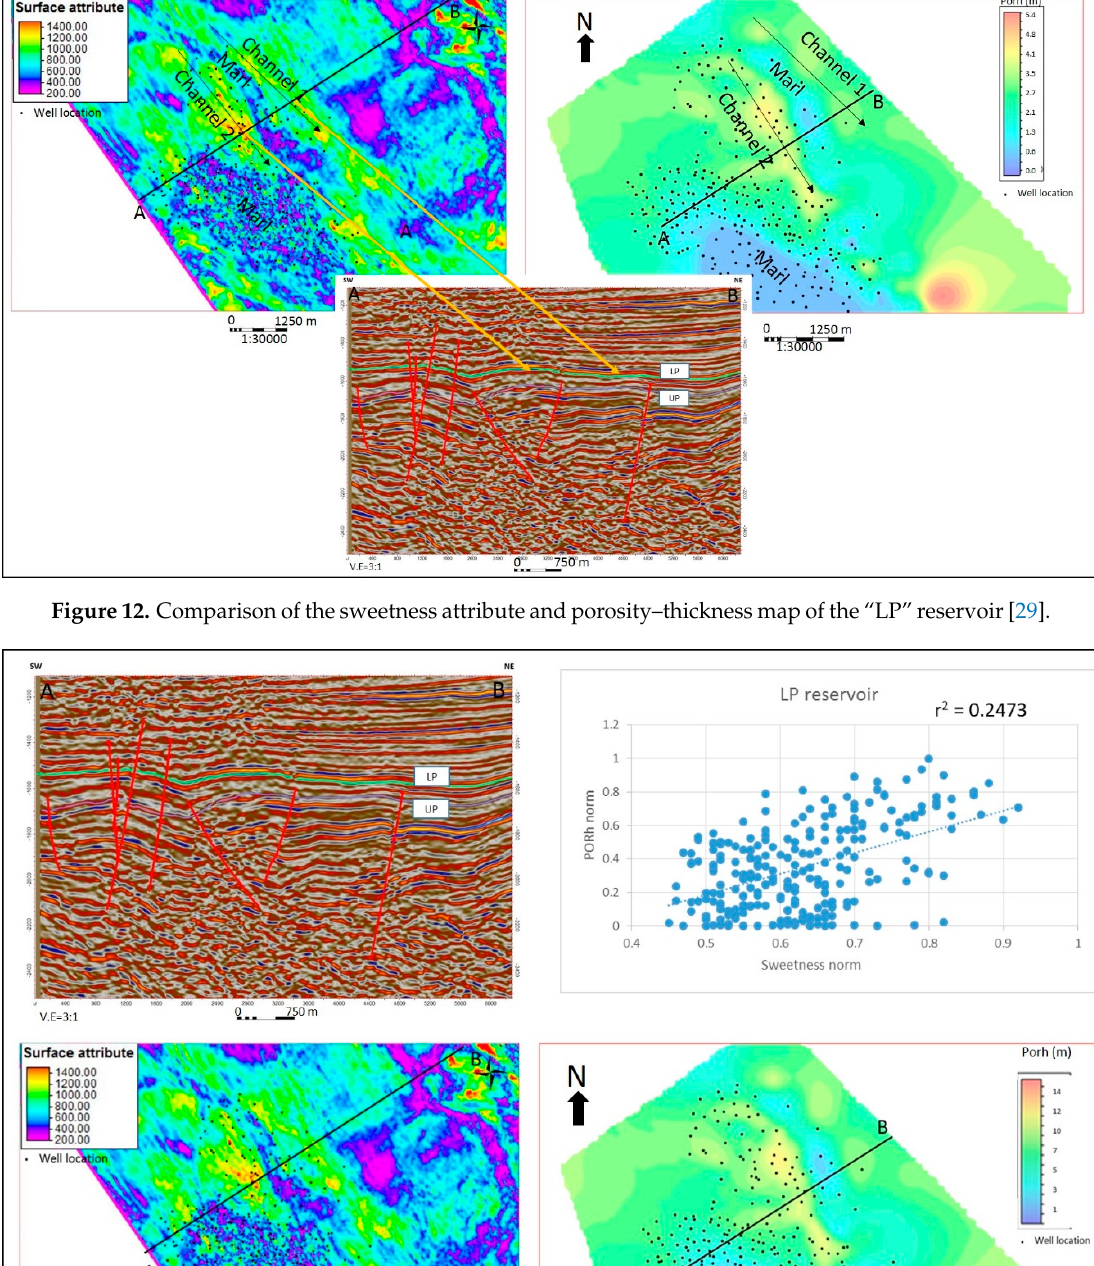
Figure 11. Comparison of the sweetness attribute and porosity–thickness map of the “UP” reservoir.